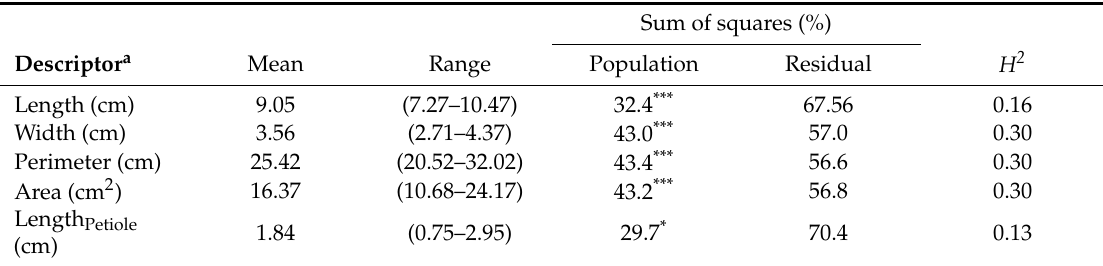
Table 5. Mean value, range, percentage of the total sum of squares for the e ff ects of population and residuals, and broad sense heritability ( H 2 ) for leaf quantitative traits ( n = 44).